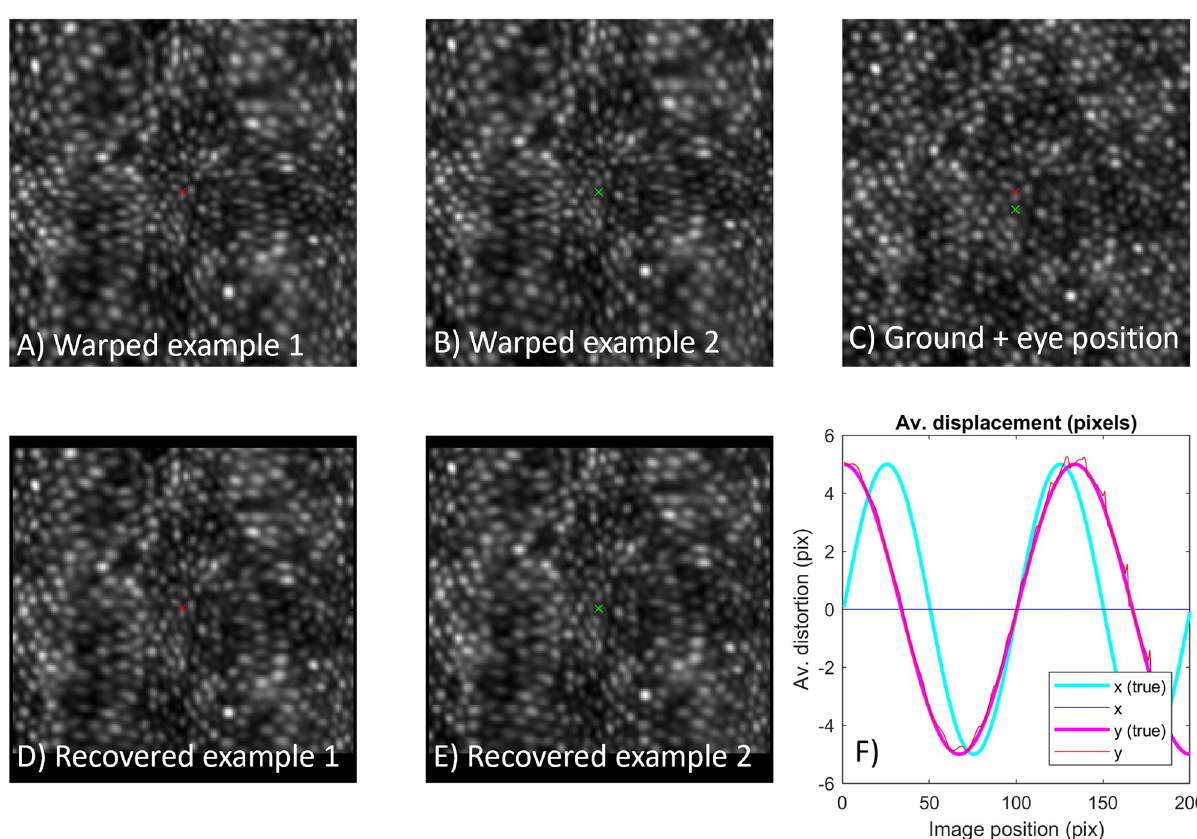
Fig 4. Example failure to correct for static distortion in 2D. Two distorted frames were generated with the eye at different positions corresponding to the coloured crosses. Generated images (A, B) and ground truth (C) correspond to those in Fig 1. Recovered images are still seen to be highly warped in the horizontal direction (D, E). This occurs because there is no information provided regarding differences in the horizontal direction (flatline in F). In the vertical direction, the use of just two frames fails to constrain the solution, producing a “shakey” appearance to the recovered distortion profile (red line in